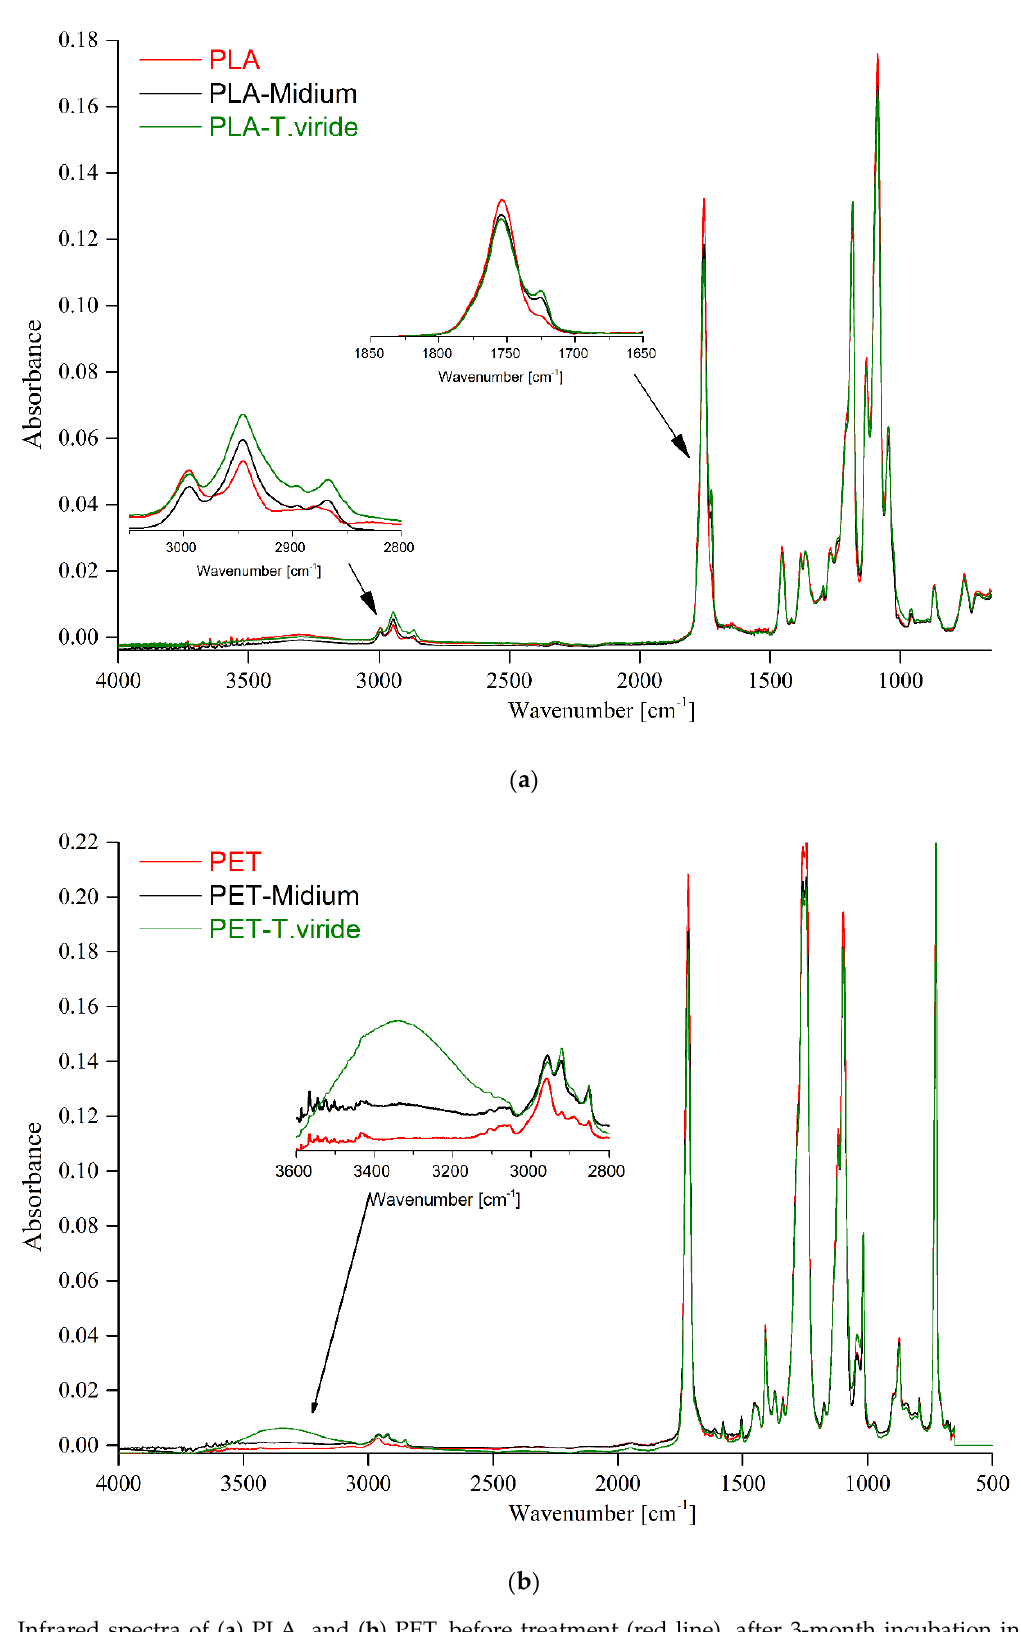
Figure 3. Infrared spectra of ( a ) PLA, and ( b ) PET, before treatment (red line), after 3-month incubation in medium (black line), and after 3-month incubation in medium- T. viride GZ1 (green line).